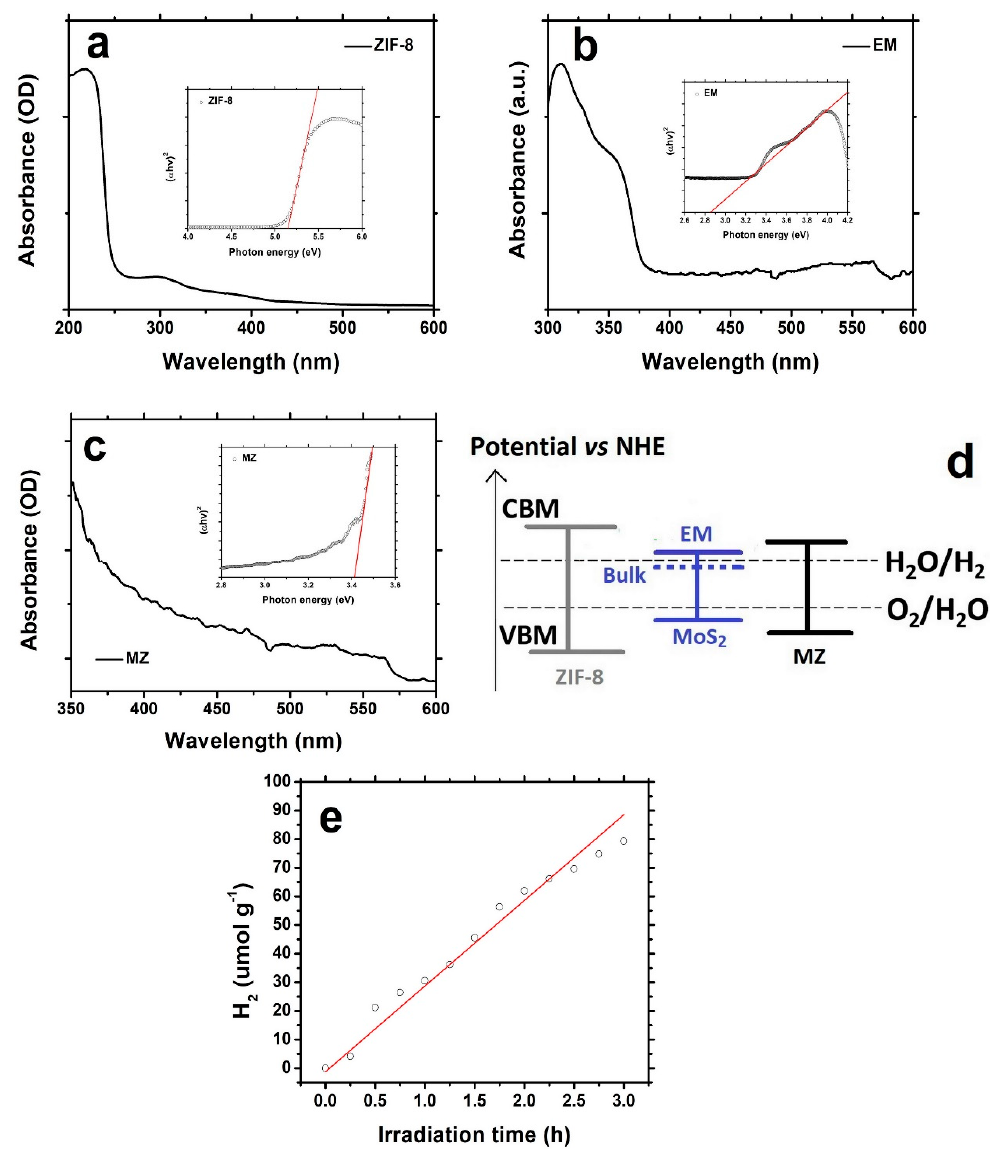
Figure 3. UV-vis absorption spectra and Tauc’s plot (inset) for band gap energy determination of ( a ) ZIF-8, ( b ) exfoliated MoS 2 (EM), and ( c ) MZ; ( d ) schematic illustration of the energy band structure of the as-prepared samples; ( e ) photocatalytic hydrogen production rate collected for MZ.